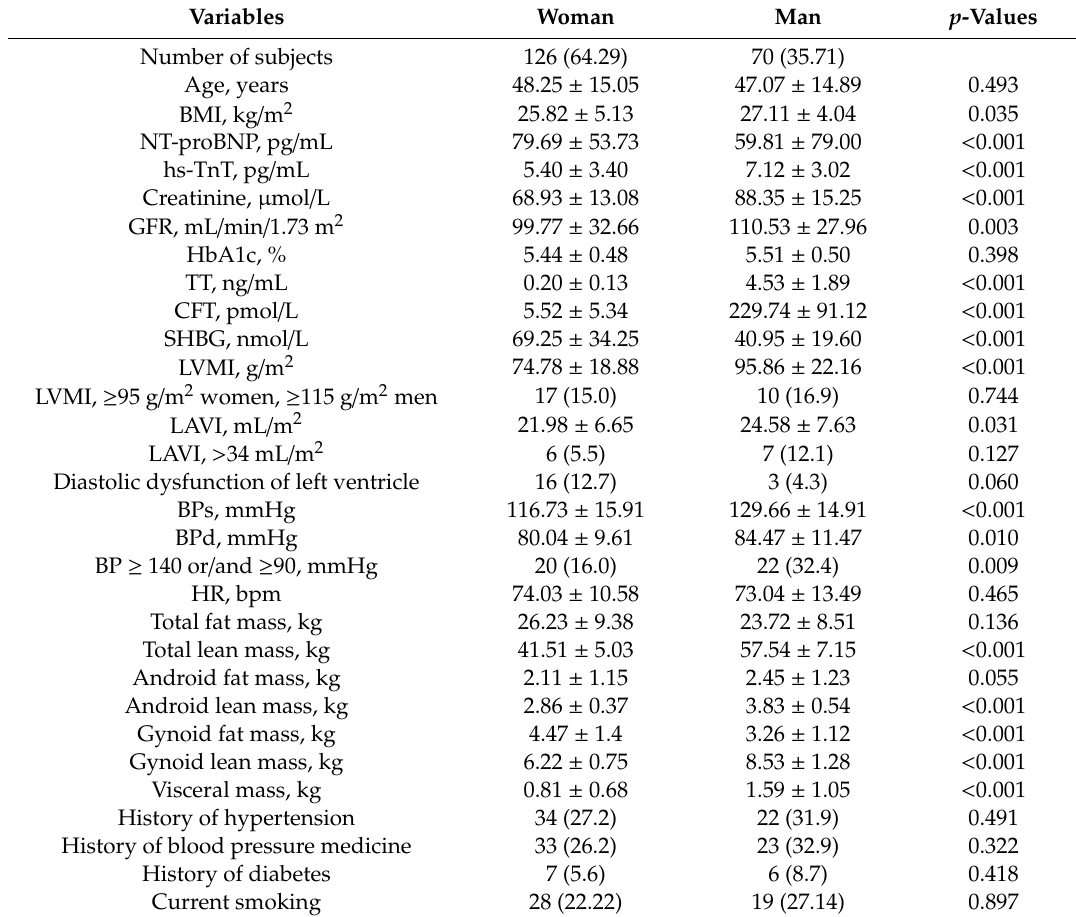
Table 2. Gender group characteristics.